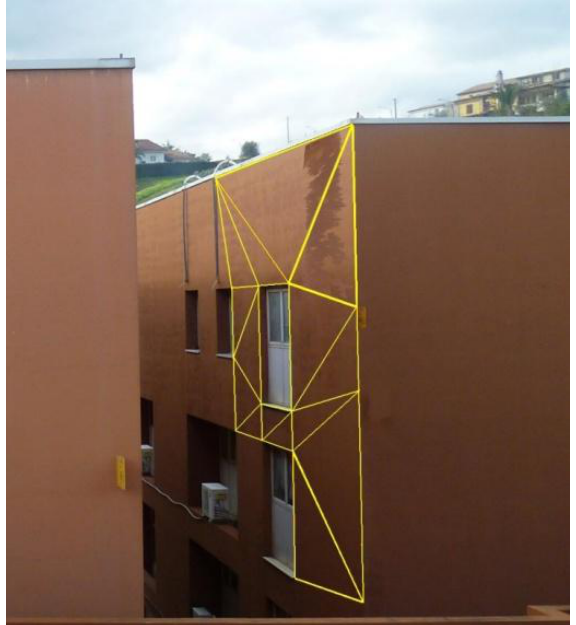
Figure 7. The new image of test 2 with the triangulation